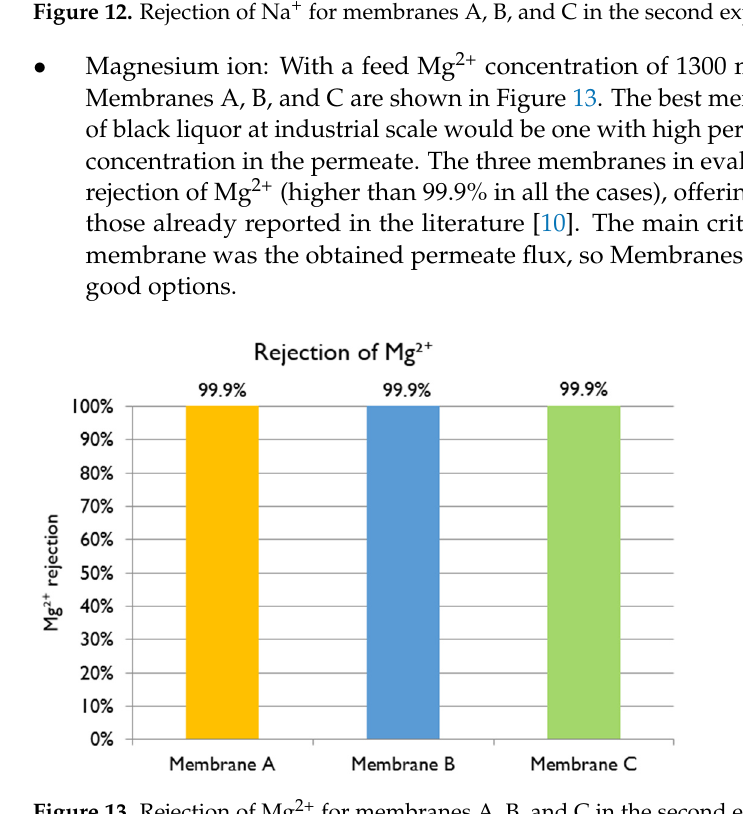
Figure 13. Rejection of Mg 2+ for membranes A, B, and C in the second